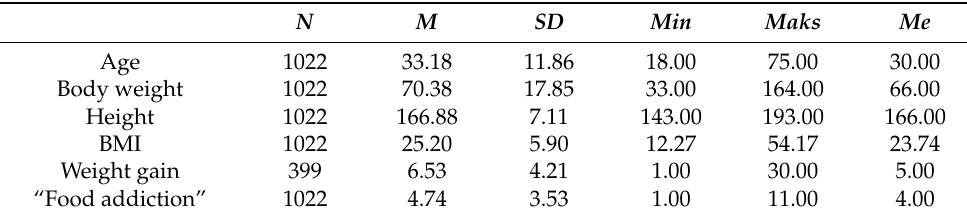
Table 2. Characteristics of the group with a description of the statistics, taking into account the average, minimum and maximum values as well as the values of the medians of the variables. N M SD